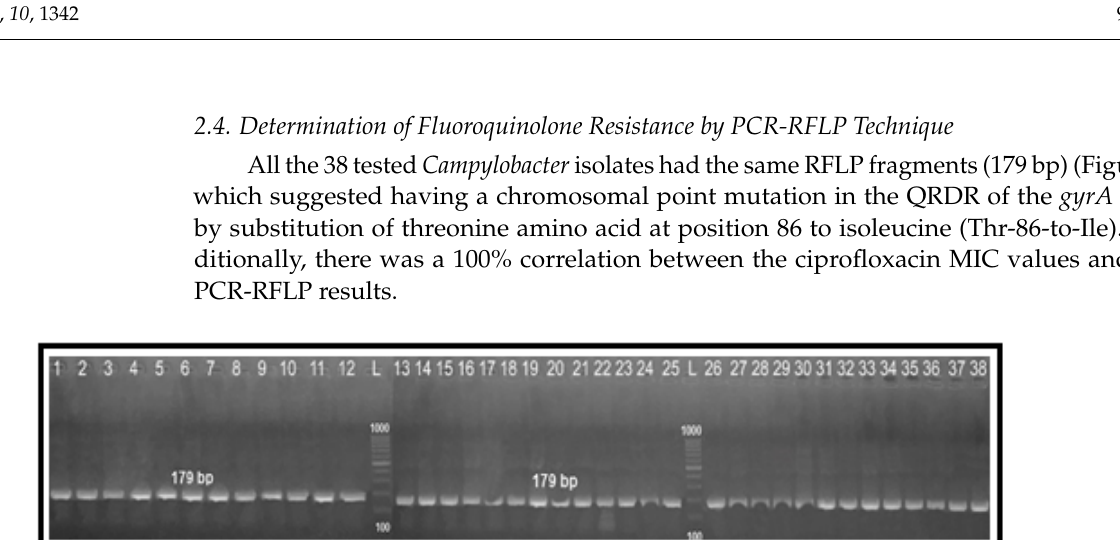
Figure 6. Prevalence of molecularly identified Campylobacter species in different samples. H: human stool swabs, Cl: chicken liver, Cbm: chicken breast meat, Ccs: chicken cloacal swabs, ns: non- significant, * p < 0.05, ** p < 0.01.